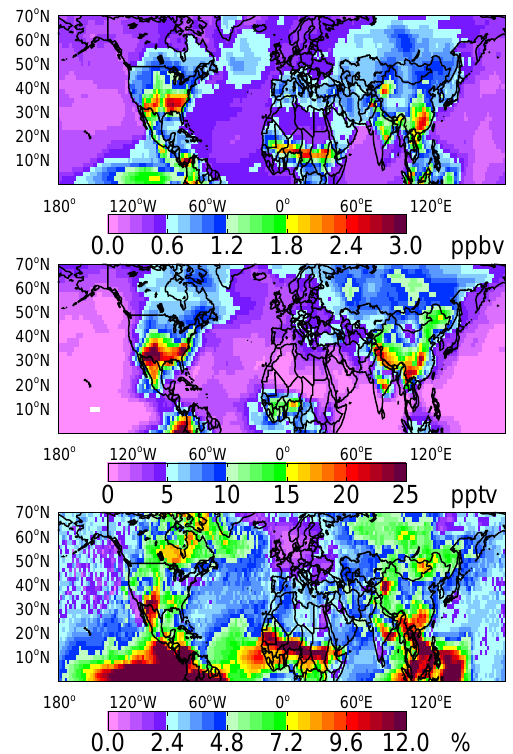
Fig. 6. Change in August mean surface O 3 (top), lower free tropo- spheric PAN (middle), and NO y deposition (bottom) when global isoprene nitrate recycling increases from 40% to 100% (SR1 r100-